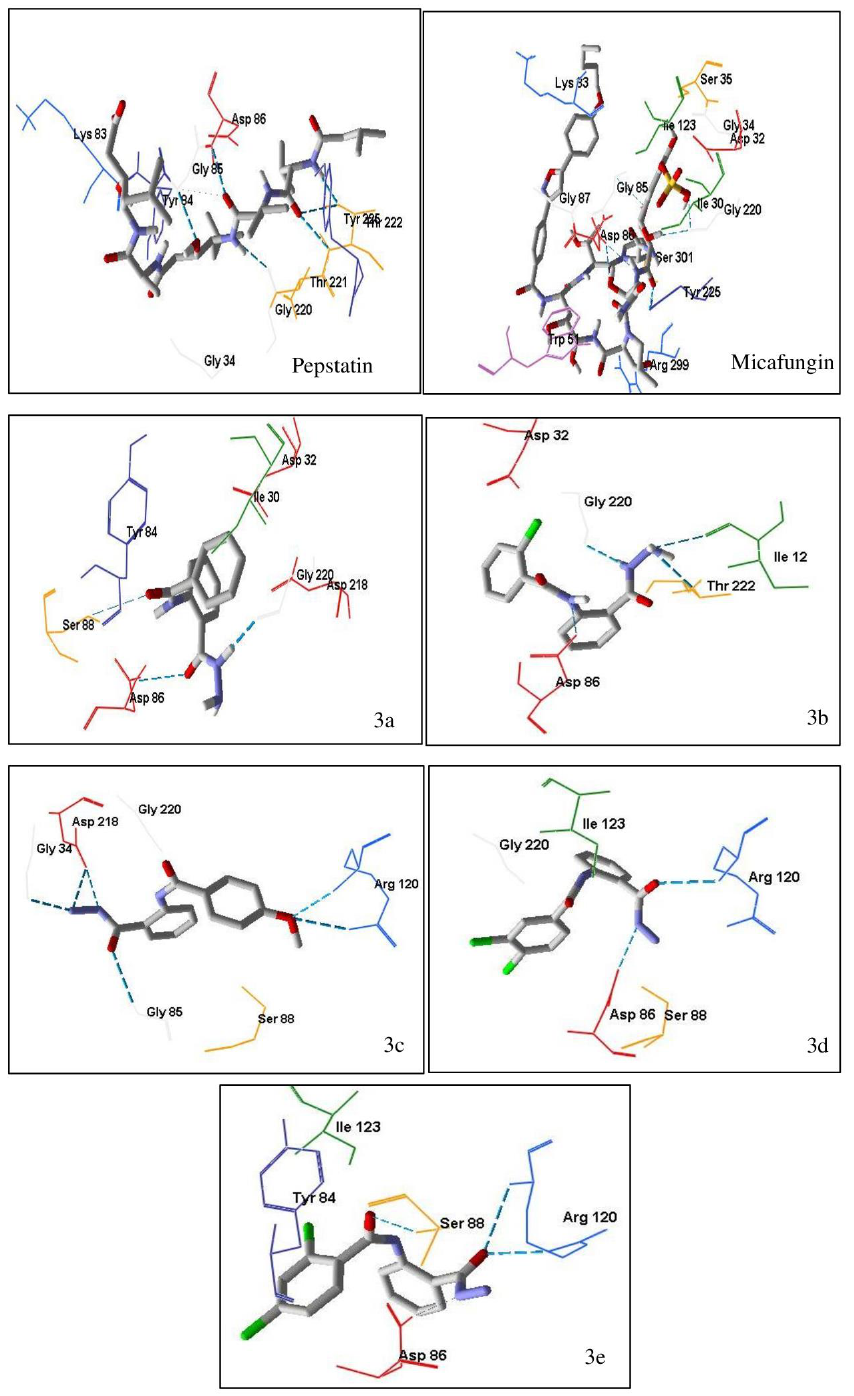
Figure 5. The molecular docking interaction between micafungin and compounds 3a – e into active site in Aspartic proteinases (Saps). Dashed line (blue color) is hydrogen bonding. The darker the blue color, the stronger hydrogen bonding and the closer the distance between the molecules. The details of color are as follows: yellow — cysteine (Cys); light blue — Asparagine (Asn); red — aspartic